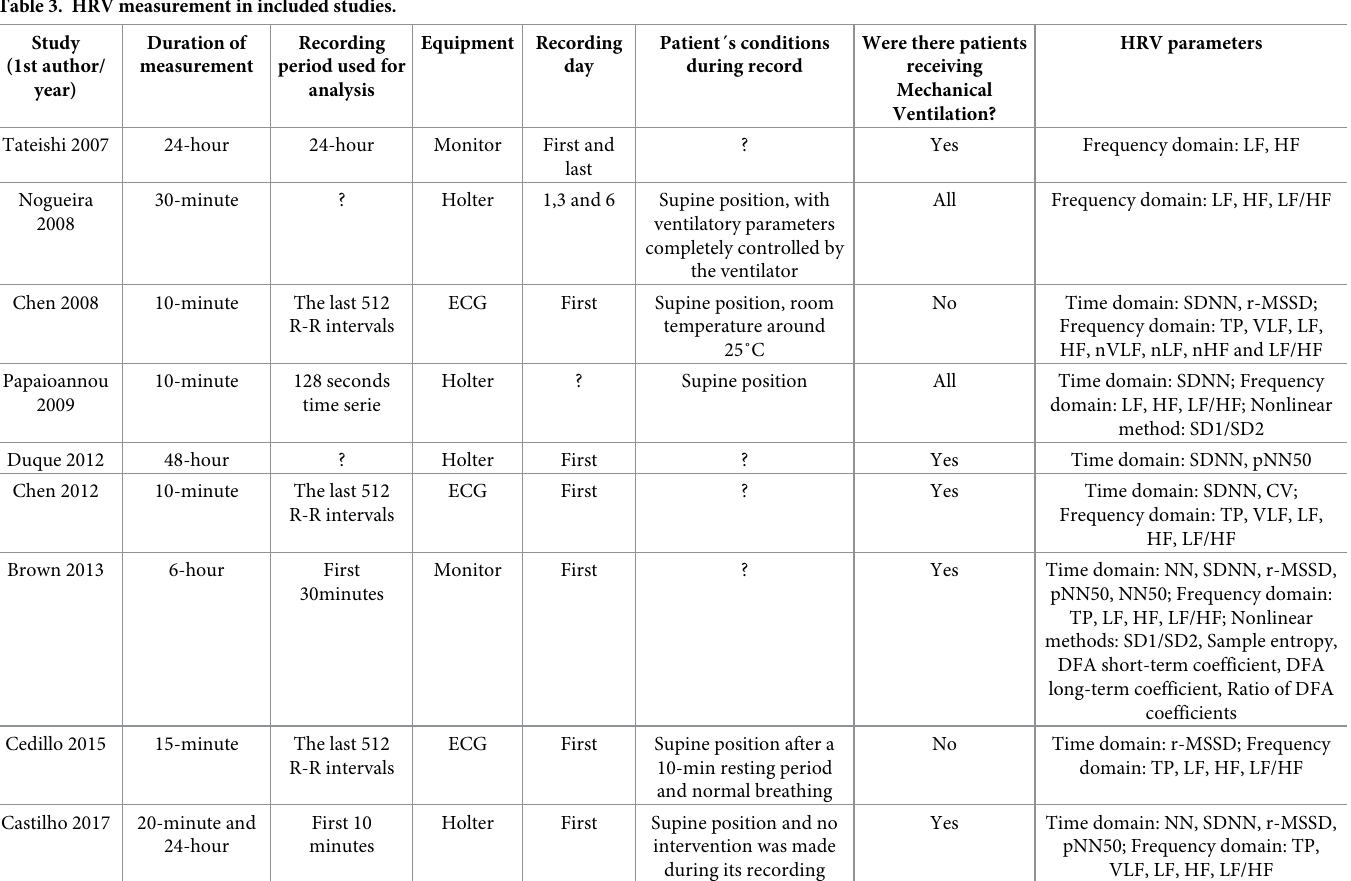
Table 3. HRV measurement in included